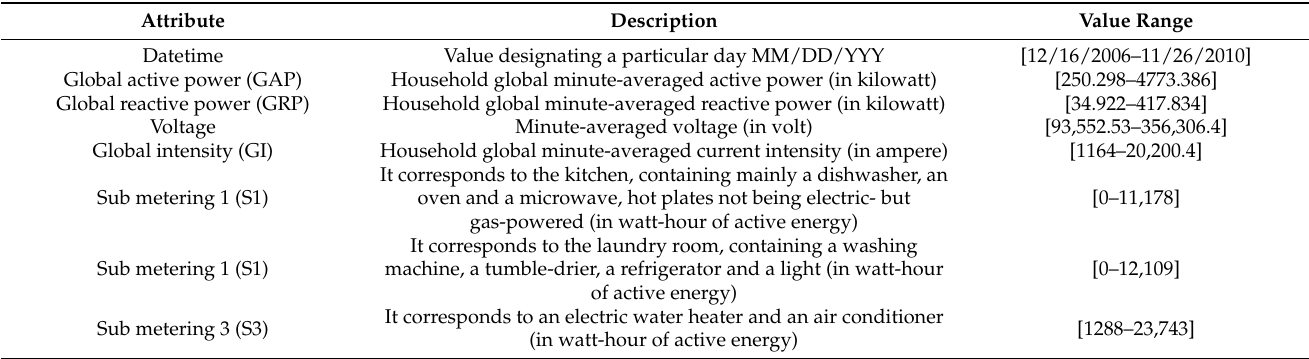
Table 3. The features of individual household power consumption dataset.